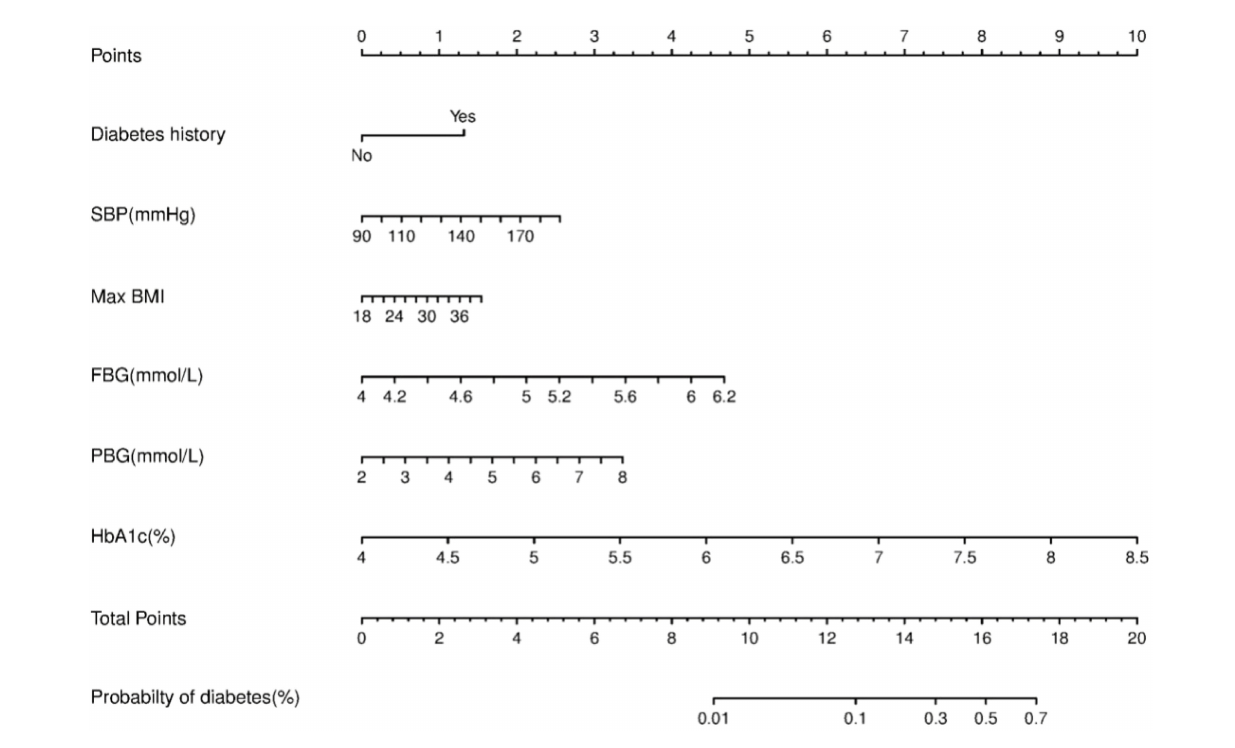
FIGURE 3 | Nomogram predictive model for diabetes in